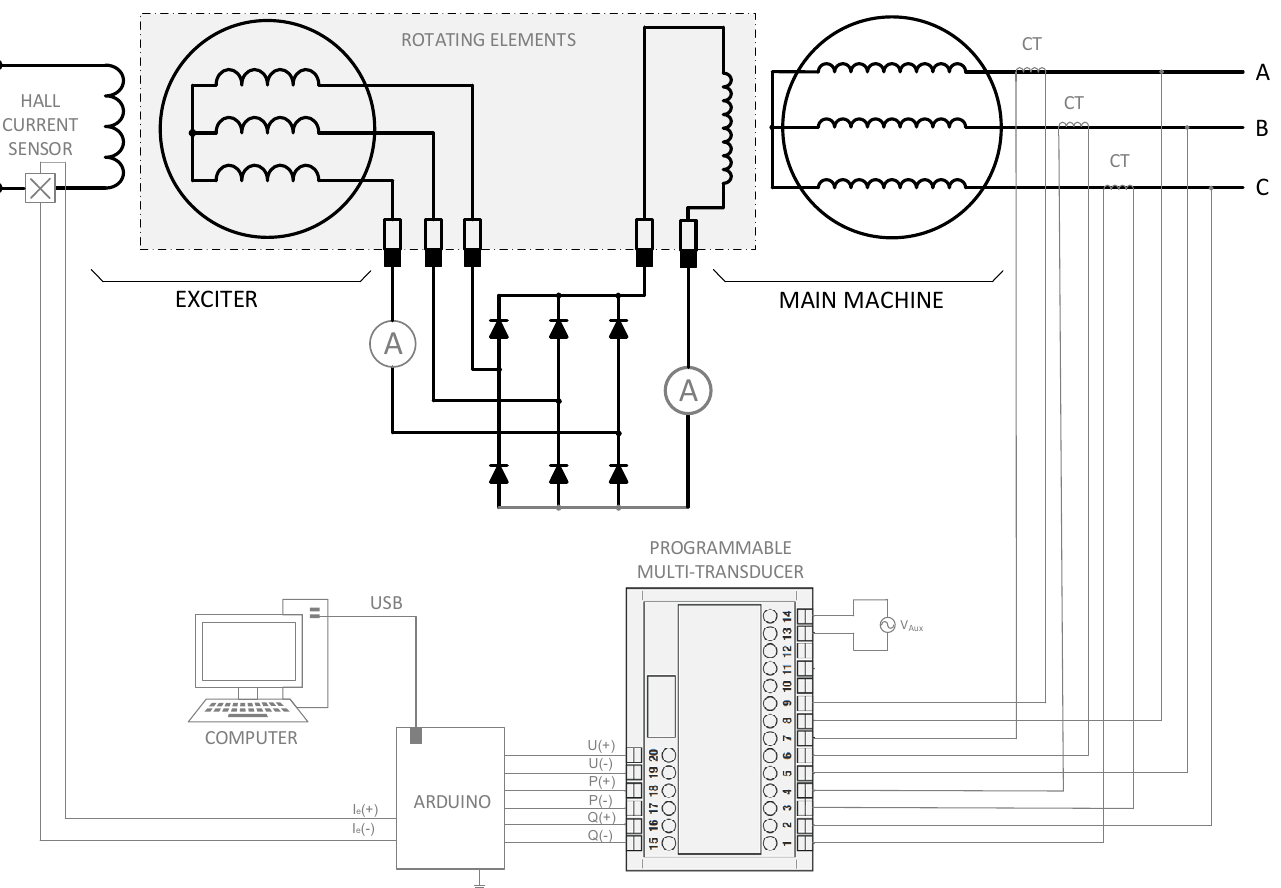
Figure 8. Schematic layout of the experimental arrangement with static rectifier. Rotating elements are contained in the areas in gray.